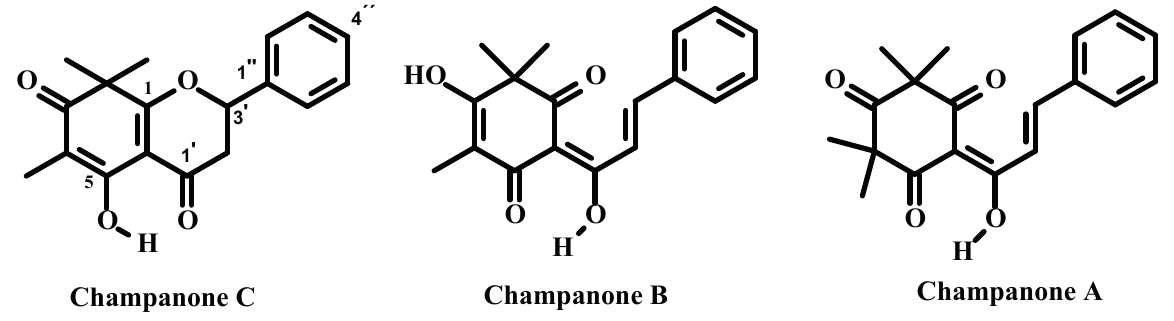
Figure 1. Structure of champanones from Campomanesia